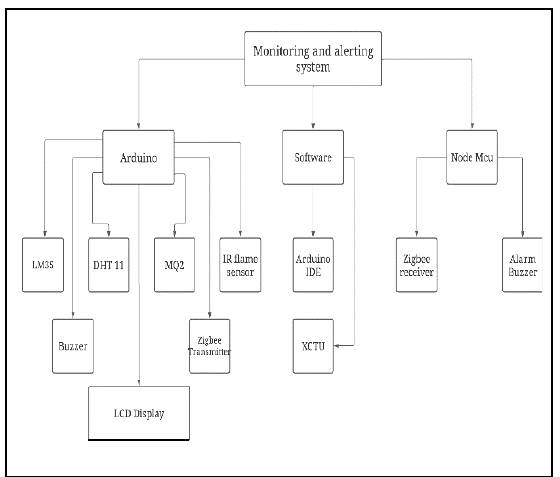
Fig. 1 : Block Diagram Of Coal Mine Safety And Monitoring